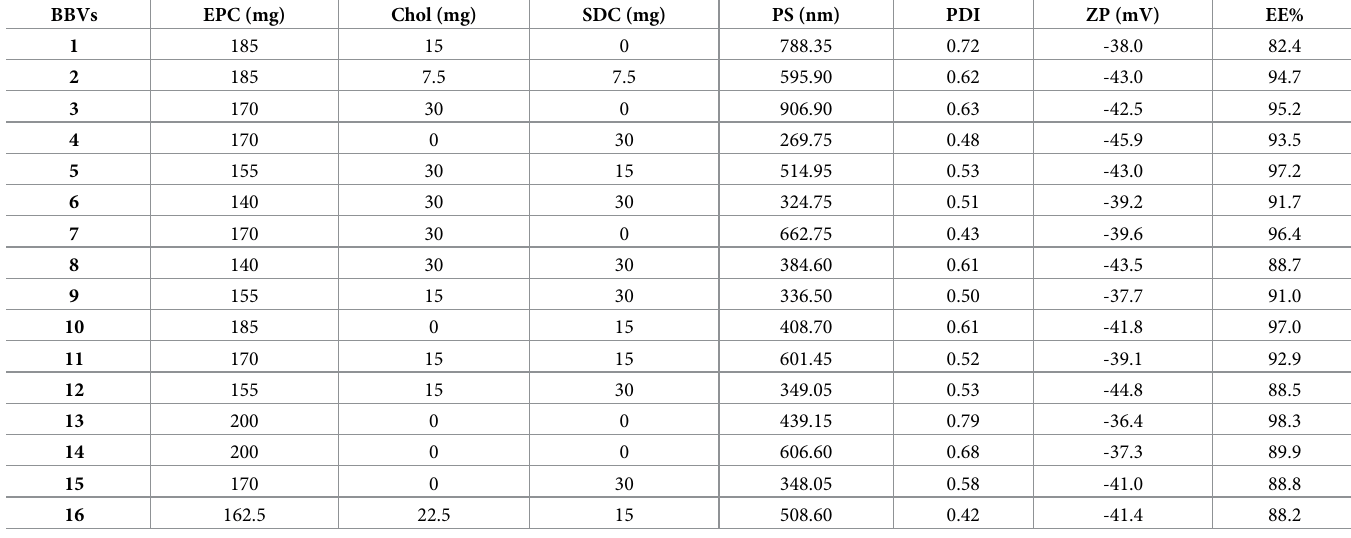
Table 1. Experimental runs, formulation variables, and measured responses of the D-optimal mixture experimental